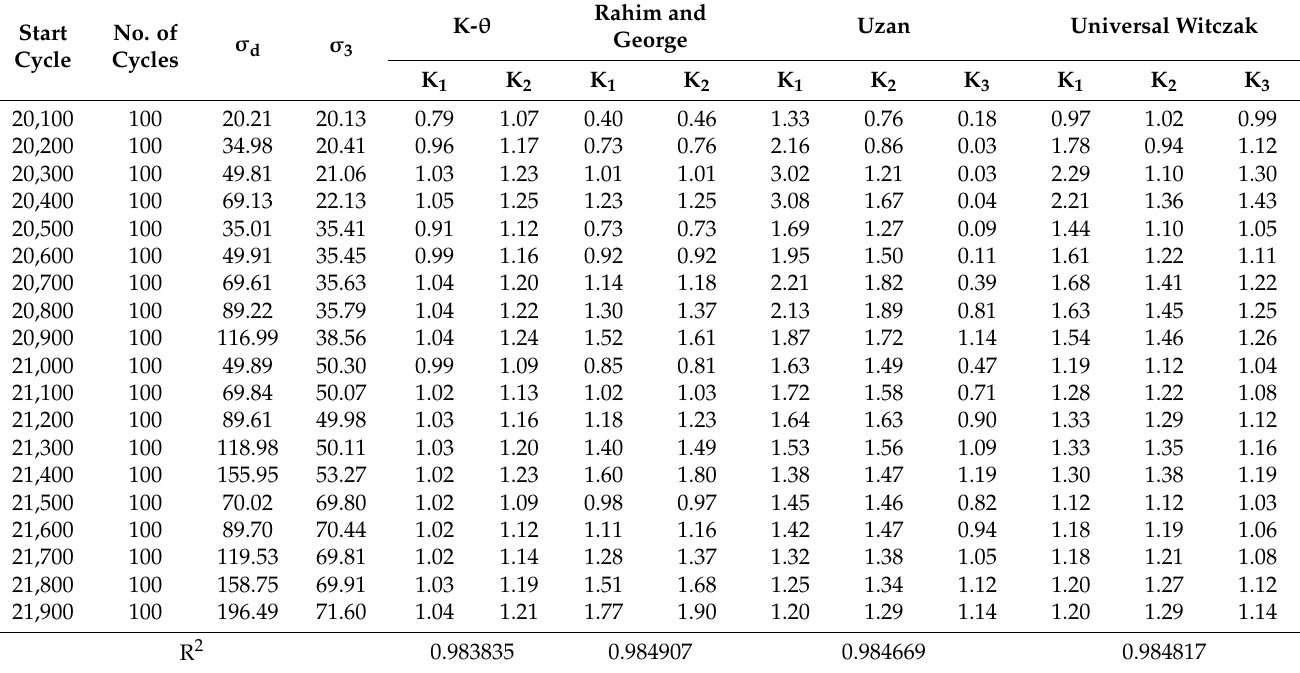
Table 2. Determination of models’ average regression coefficients for specimen SP1.